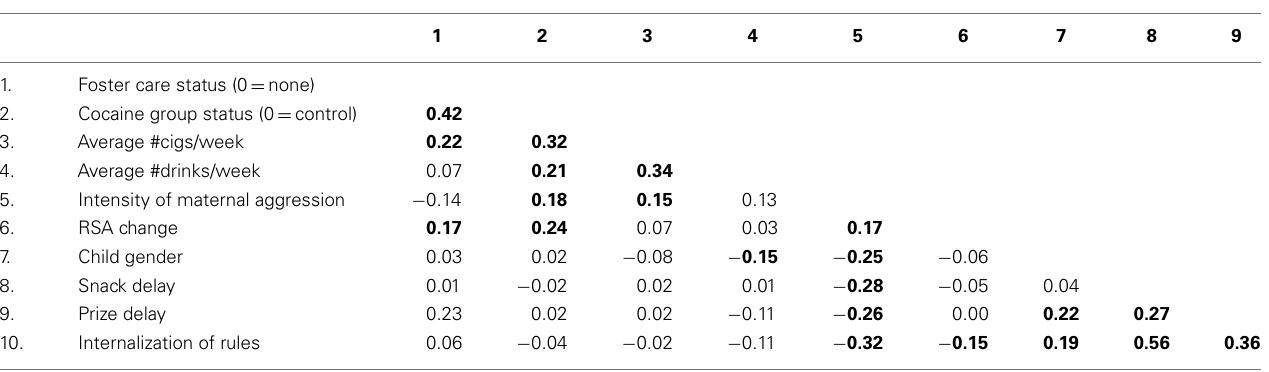
Table 2 | Correlations among variables included in model